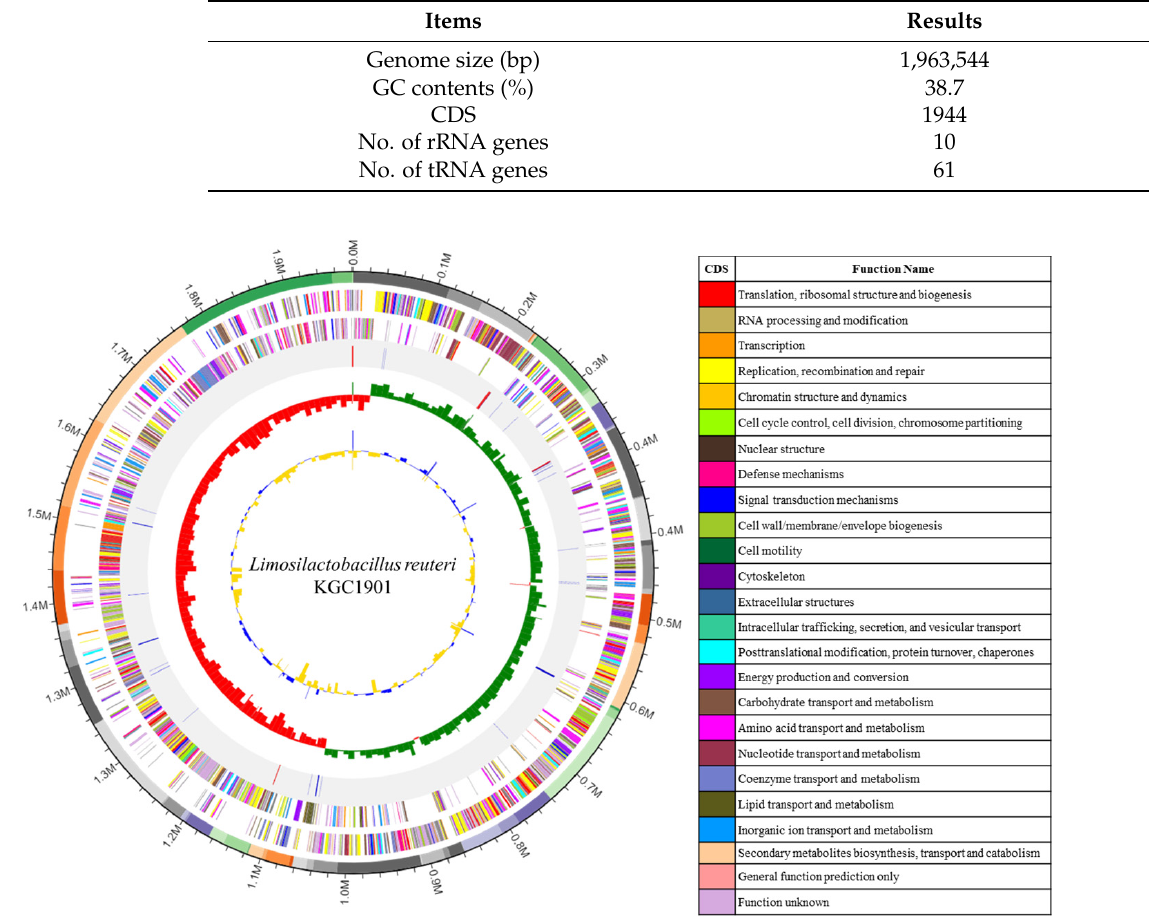
Table 1. Genomic characteristics of Limosilactobacillus reuteri KGC1901.